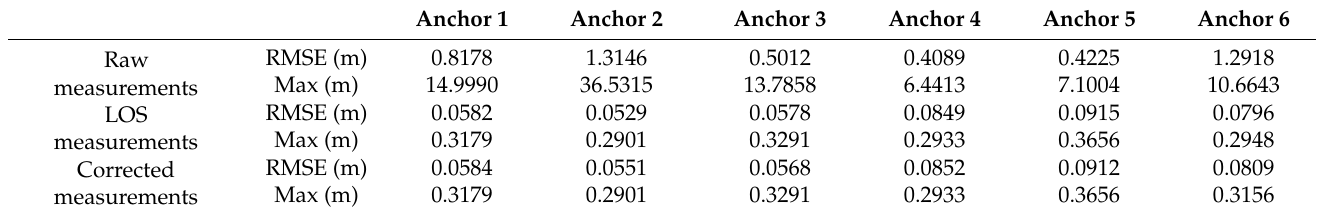
Figure 8. Ranging errors of the UWB raw measurements (green), LOS measurements (blue) and pseudo measurements (red) for different anchors: ( a ) anchor 1, ( b ) anchor 2, ( c ) anchor 3, ( d ) anchor 4, ( e ) anchor 5, and ( f ) anchor 6. Table 2. Performance of different UWB measurements. Four decimal places are given to better compare the difference between the LOS and corrected